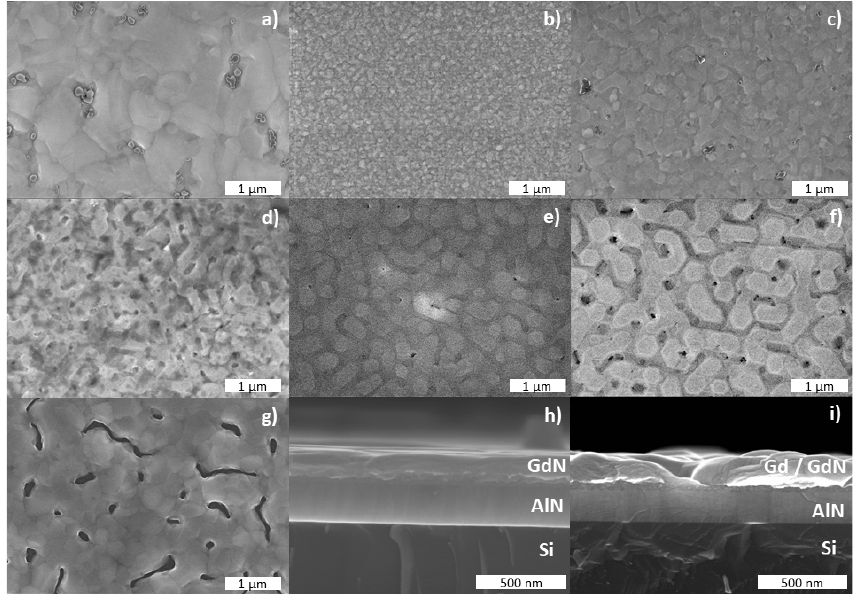
Figure 1. Secondary electron SEM mages of ( a ) 80 °C, ( b ) 210 °C, ( c ) 240 °C, ( d ) 255 °C, ( e ) 270 °C, ( f ) 330 °C and ( g ) 400 °C Gd films grown on AlN (0001) samples and cross sections of the ( h ) 330 °C and ( i ) 400 °C films. Cross sections were prepared by inducing a clean fracture in the underlying Si wafer.